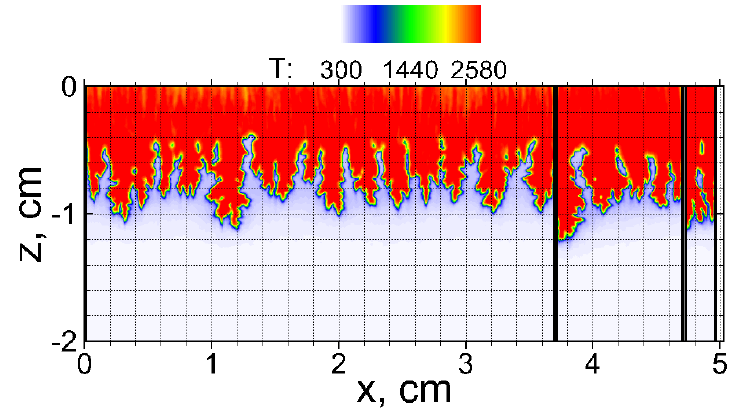
Figure 4. Flame structure in the stoichiometric hydrogen–oxygen microfoam in the tubes of different widths (from left to right, 3.7 cm, 1.0 cm, and 0.25 cm) at the same time